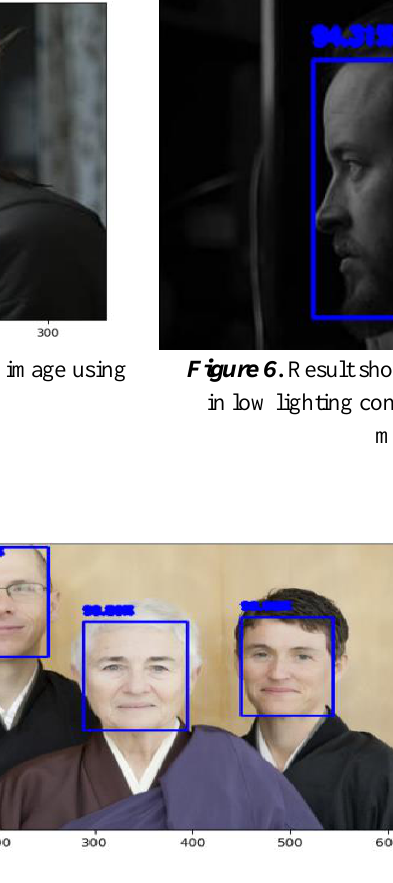
Figure 7. Result showing multiple face detection in image using our proposed model